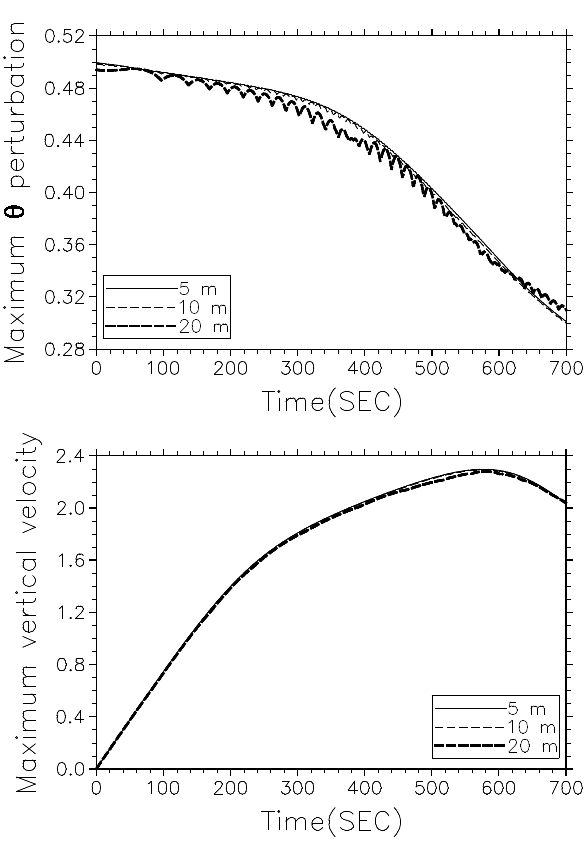
FIG. 13. Domain maximum potential temperature perturbation (top) and vertical wind 2 Figure 13. Domain maximum potential temperature perturbation (top) and vertical wind (bottom) for the rising thermal bubble test. (bottom) for the rising thermal bubble test. All simulations use 5th-order basis polynomials 3 All simulations use fifth-order basis polynomials per element, and per element, and the vertical resolutions are the same as the horizontal resolutions. 4 the vertical resolutions are the same as the horizontal 5